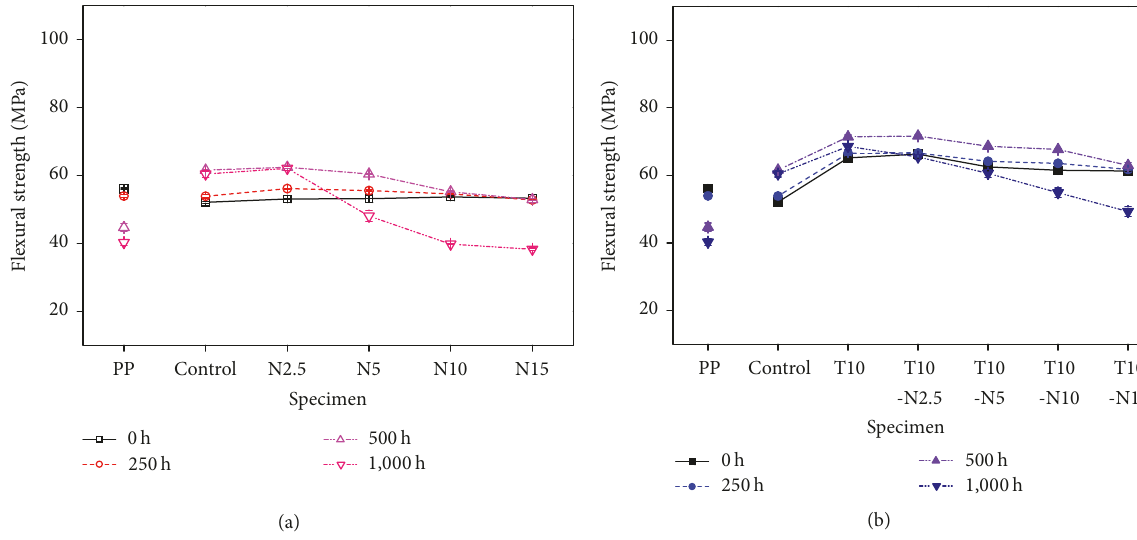
Figure 3: Flexural strength of pure PP, control, and PP-based composites depending on accelerated weathering time: (a) NCC-only; (b)